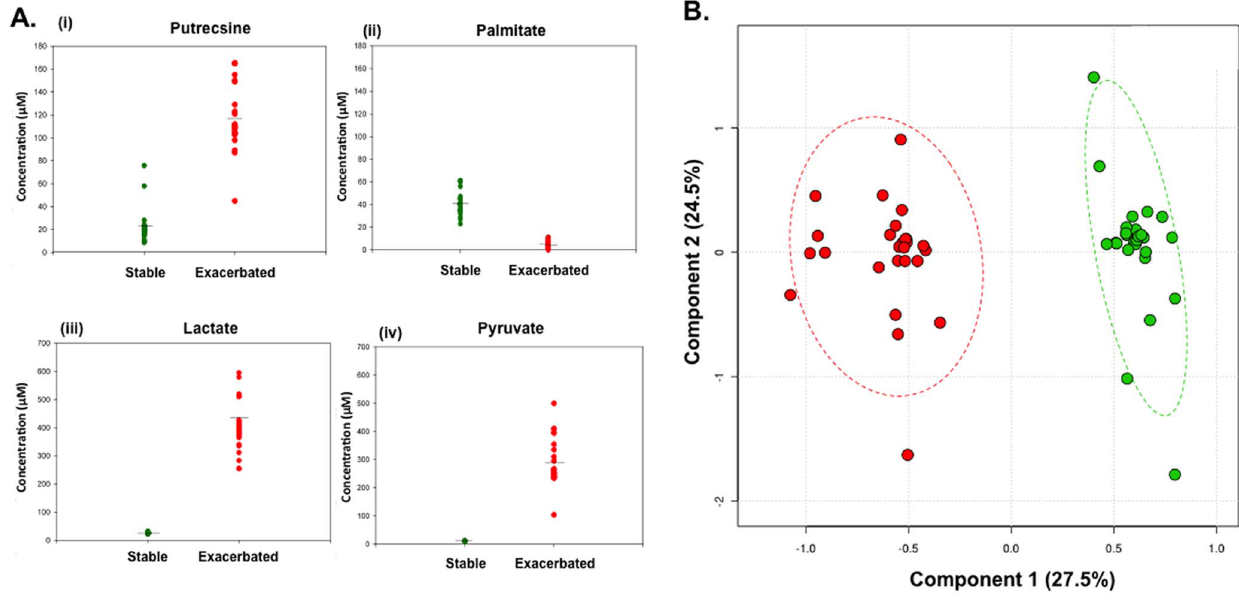
Figure 6. Concentrations of lactate (i), pyruvate (ii), putrescine (iii) and palmitate (iv) detected in sputum samples taken from 26 CF patients during a period of stability and presenting with pulmonary exacerbation (A). Each dot represents an individual patient. Data are given as the average values measured in triplicate (metabolite concentrations are described as m M unless otherwise stated and means 6 standard deviations are reported). (B) PLS-DA plots of metabolite profile of sputum taken from 26 CF patients during a period of stability and presenting with pulmonary exacerbation. Stable subjects (green) vs. exacerbated subjects (red); R 2 =0.95, Q 2 =0.93 for a two-component model. The ellipses represent the 95% confidence region. Permutation tests (n=1,000) validated the model (p , 0.001).